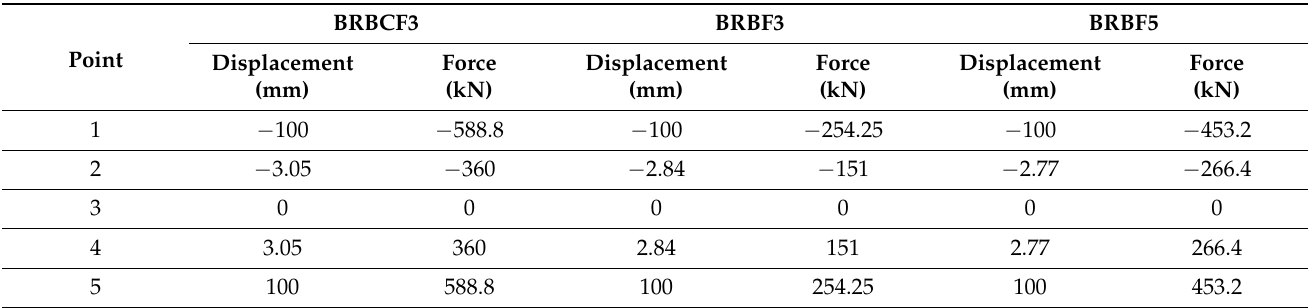
Table 5. Input multilinear force-displacement relation parameters of